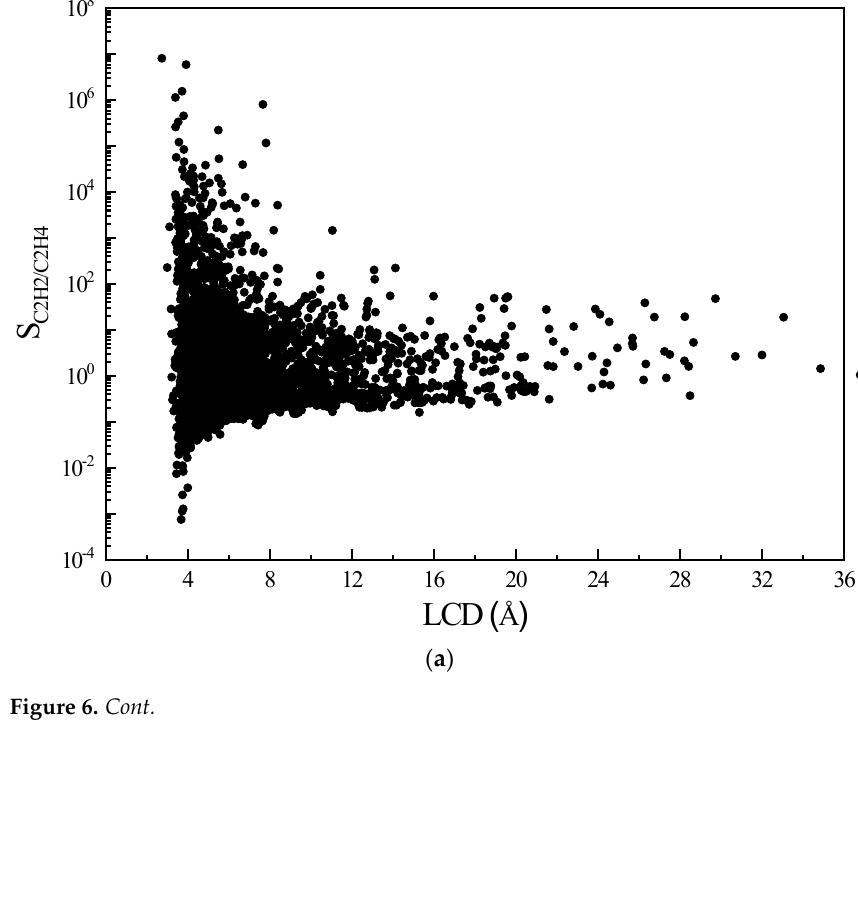
( b ) Figure 6. Adsorption selectivity of MOF with respect to ( a ) C 2 H 2 /C 2 H 4 and ( b ) C 2 H 6 /C 2 H 4 versus LCD.